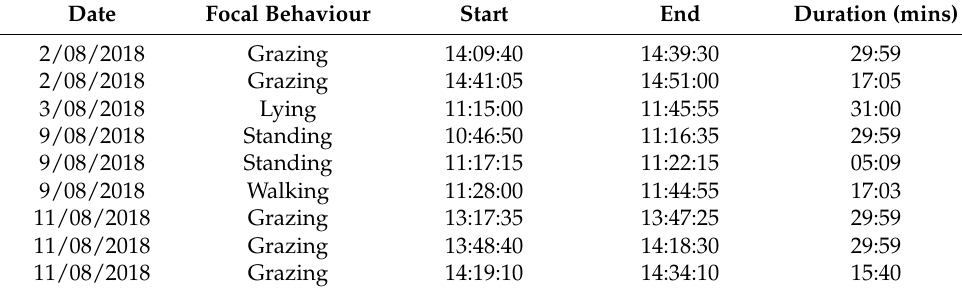
Table 1. Starting times and duration of focal behaviour observation sessions recorded by video across three experimental periods on ewe lambs ( n = 6) fitted with a collar mounting an Actigraph ® wGT3X-BT accelerometer sensor. Focal